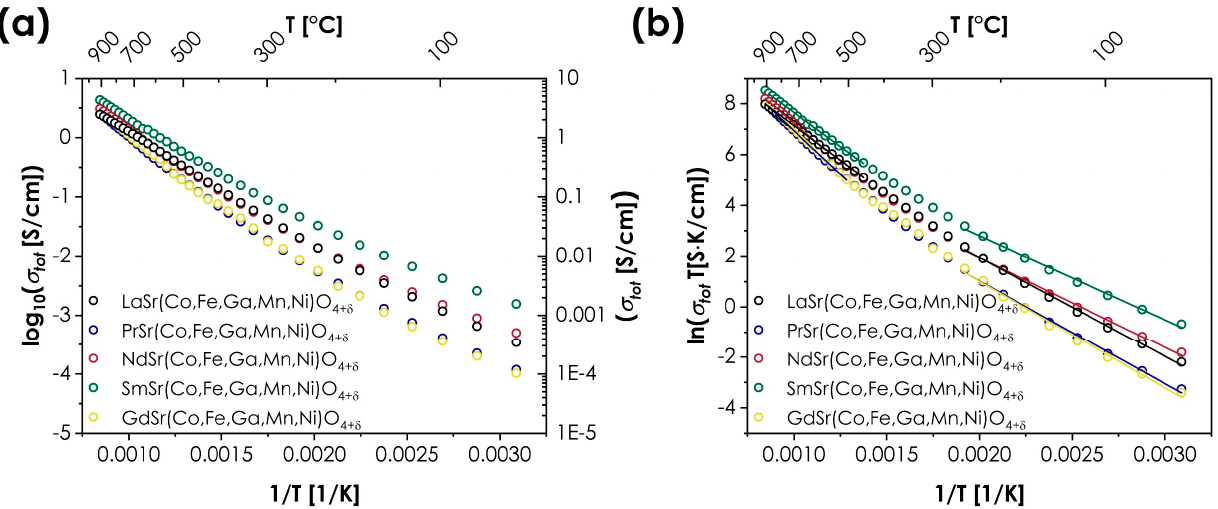
Figure 4. Total conductivity values for the LnSr(Co,Fe,Ga,Mn,Ni)O 4+ δ series (Ln = La, Pr, Nd, Sm, or Gd): ( a ) as log 10 ( σ ) = f(1/T); ( b ) as ln( σ T ) = f (1 /T ). Table 3. The determined values of energy of activation for the LnSr(Co,Fe,Ga,Mn,Ni)O 4+ δ series (Ln = La, Pr, Nd, Sm, or Gd). The maximum value of total conductivity is also provided. E a (eV) T (°C) σ max (S/cm)